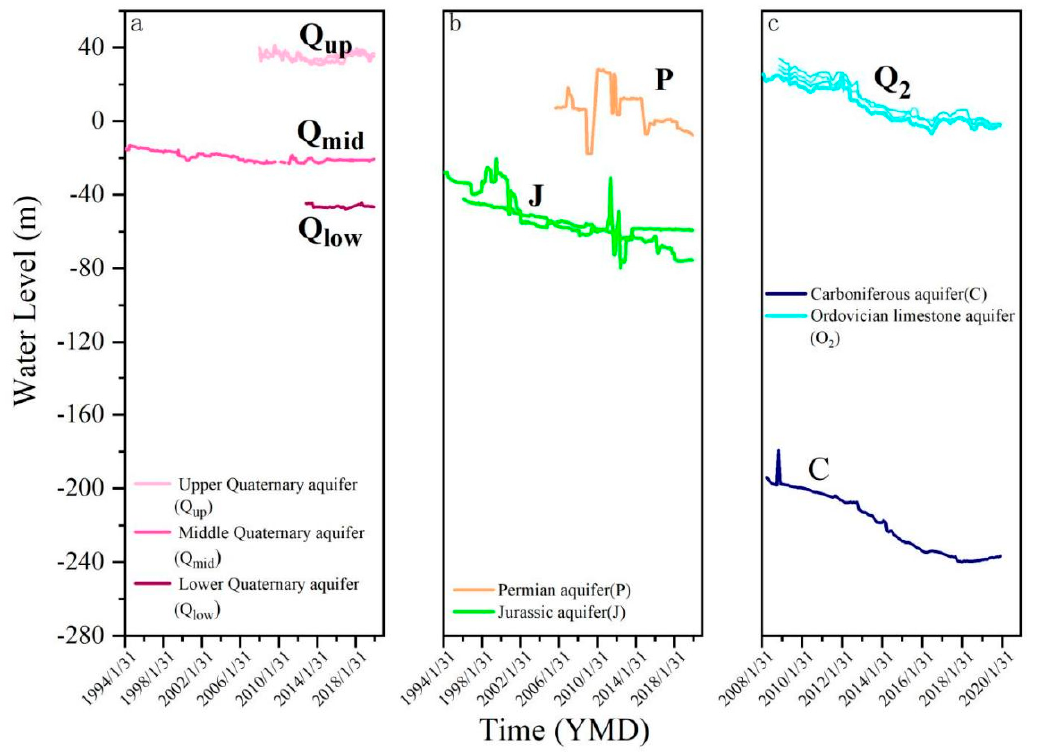
Figure 8. Water level-time relationship diagram of the Dongtan Coal Mine: ( a ) Quaternary aquifer (Q up , Q mid , Q low ); ( b ) Jurassic and Permian aquifer (J and P); ( c ) Carboniferous and Ordovician limestone aquifer (C and O 2 ).